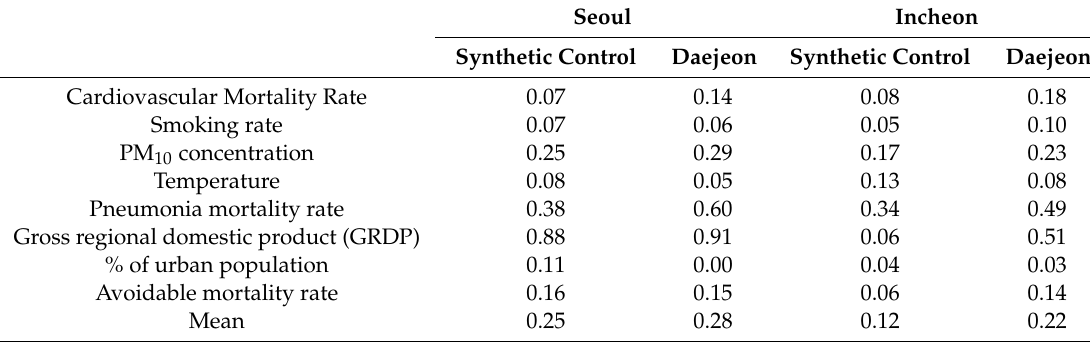
Table 2. Normalized root mean squared errors (NRMSEs) in synthetic controls and